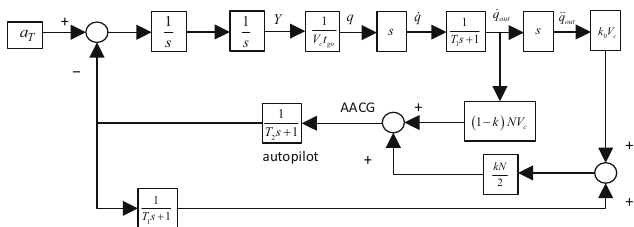
Figure 5: Second - order linearized AACG guidance system model.